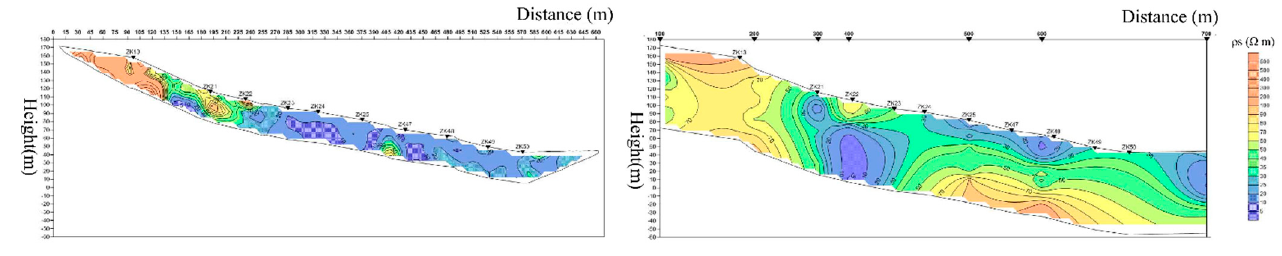
Figure 8. Geophysical section of 1 − 1.